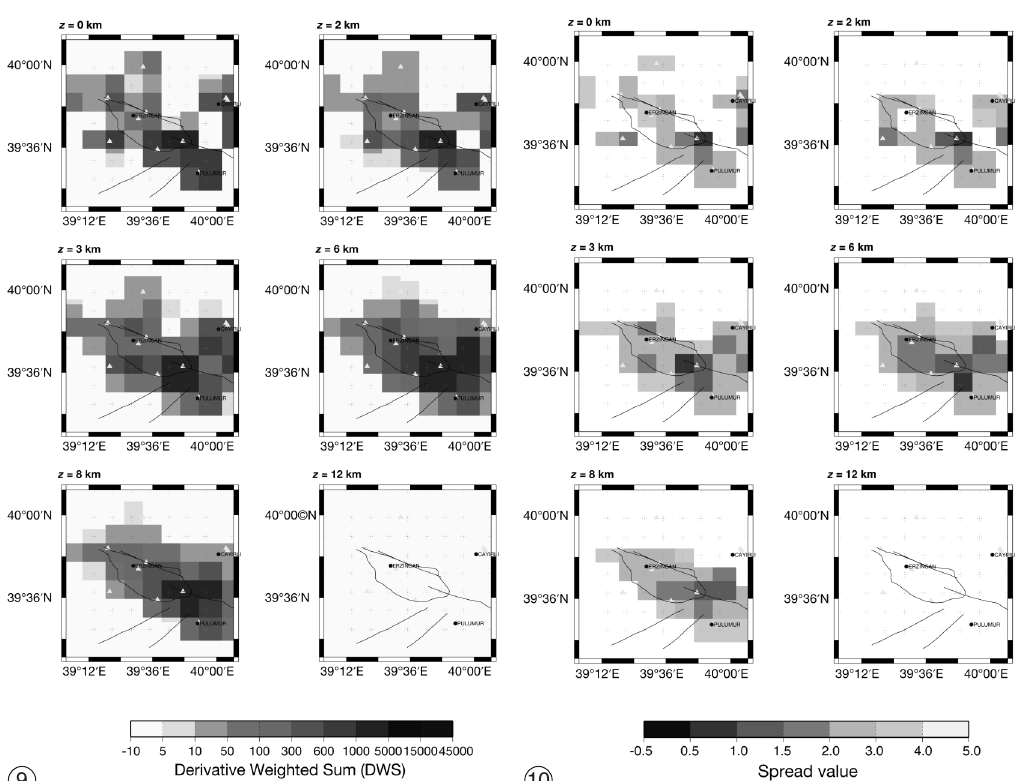
Fig. 9. Derivative Weighted Sum (DWS) distributions in the layers for the S -wave model. Fig. 10. Spread function values in the layers for the S -wave